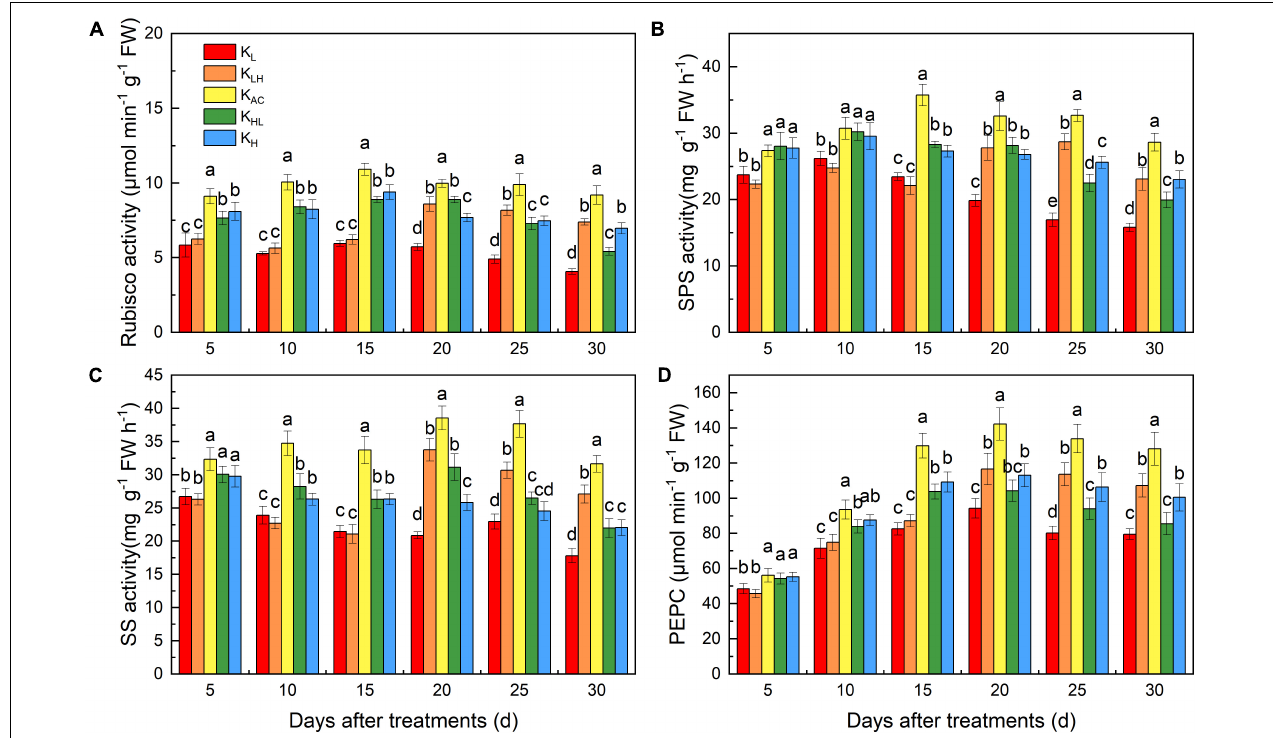
FIGURE 5 | Effects of different K treatments on the Rubisco (A) , SPS (B) , SS (C) and PEPC (D) activities in the leaves of M9T337 rootstocks. Data show the means ± standard deviation of three independent samples. Different letters on vertical bars indicate significant differences ( P < 0.05). Rubisco, ribulose-1,5-bisphosphate carboxylase-oxygenase; SPS, sucrose phosphate synthase; SS, sucrose synthase; PEPC, phosphoenolpyruvate